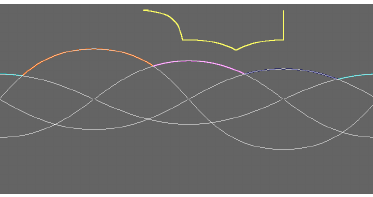
Figure 7. Theoretical lines (white) for connectivity test. The colored lines compose the primitive outline detected.